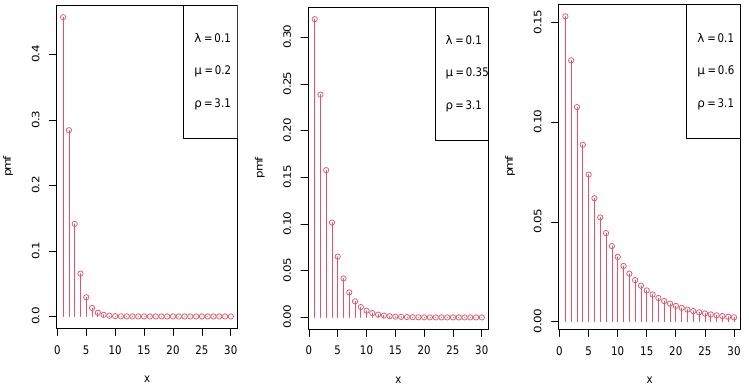
Figure 1. Various shapes of the PMF of the LIPD when λ increases.